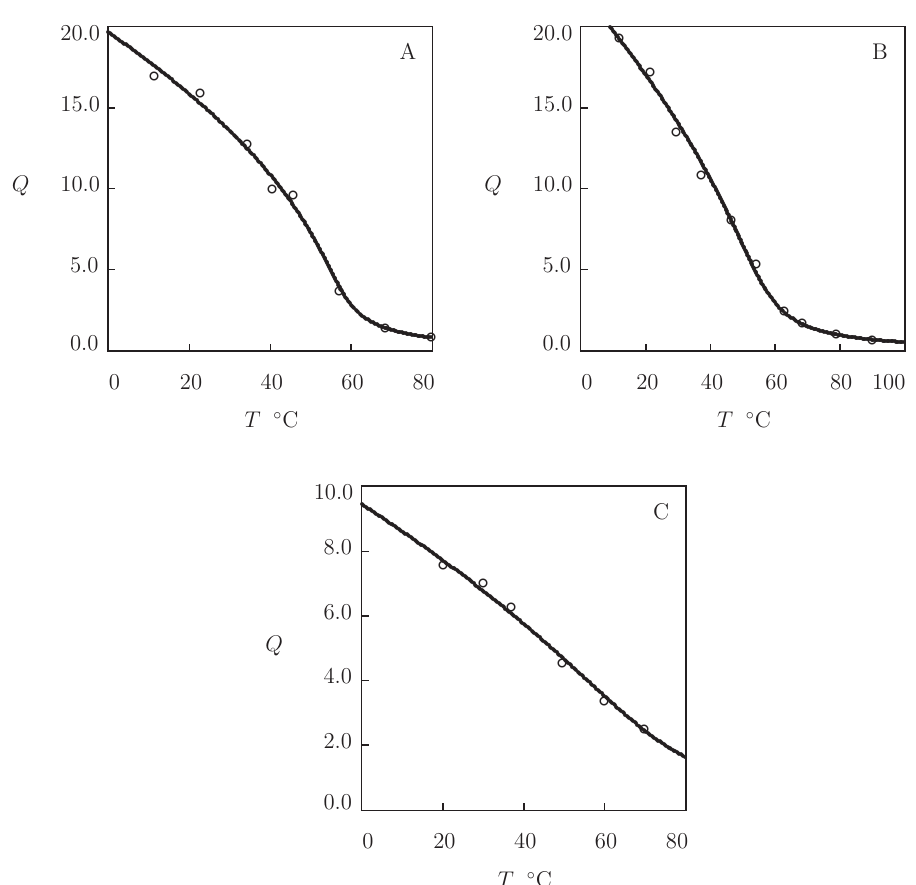
Figure 8. Degree of swelling Q versus temperature T . Circles: experimental data on POx gels (( A ) PEtOx [88], ( B ) PEtOx [89], and ( C ) PIPOx [90]). Solid lines: results of